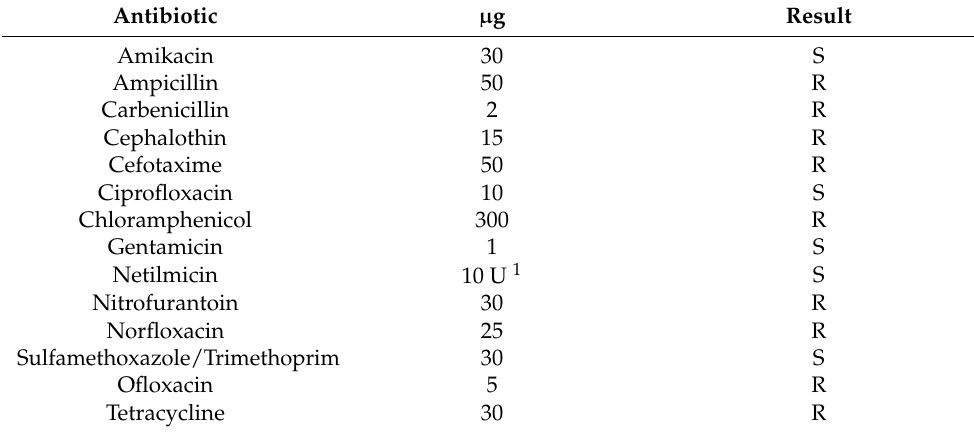
Table 1. Antibiogram for E. coli ATCC 25922.